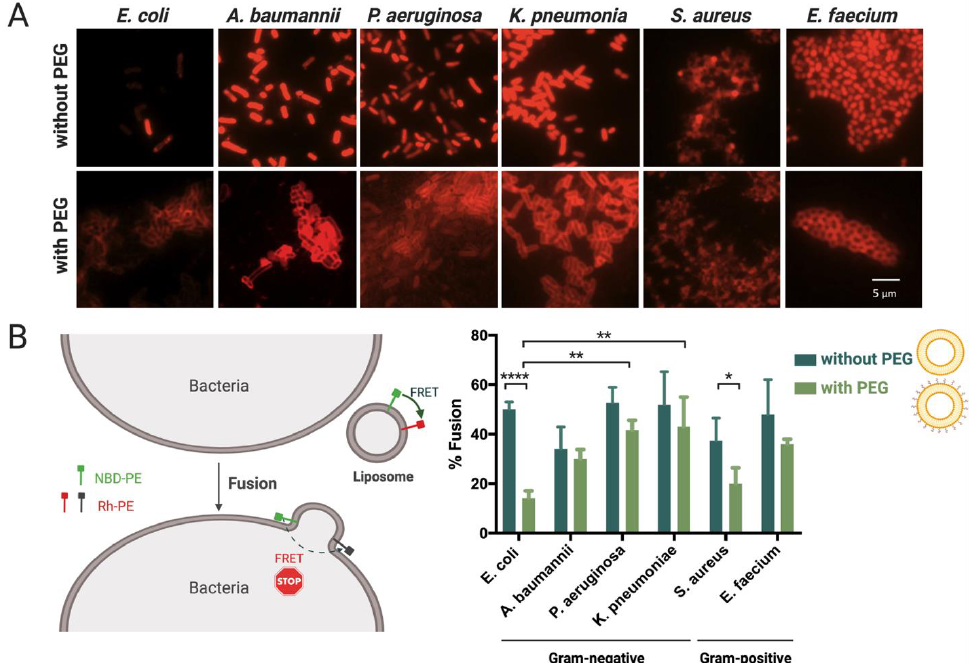
Figure 3. Interaction and fusion of liposomes, with and without DSPE-PEG, with clinically relevant bacteria. ( A ) Repre- sentative epifluorescence microscopy pictures of bacteria incubated with Rh-labeled liposomes. Scale bar represents 5 μ m. ( B ) Percentage of Rh/NBD liposomes fused with bacteria. Three independent experiments were done. Results are repre- sented as mean values and respective standard deviations. Statistical differences are indicated when appropriate ( p ≤ 0.0001, ****; p ≤ 0.01, ** ; and p ≤ 0.05, *). Figure 3B ( left ) was created with BioRender.com. (Accessed on 1 June 2021).